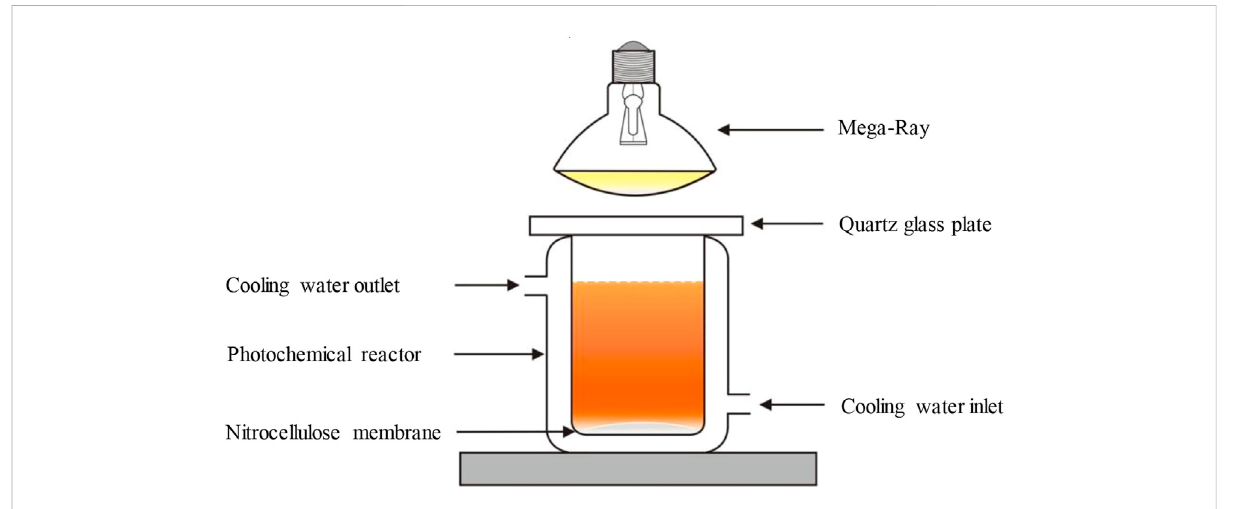
FIGURE 1 Schematic illustration of photodegradation